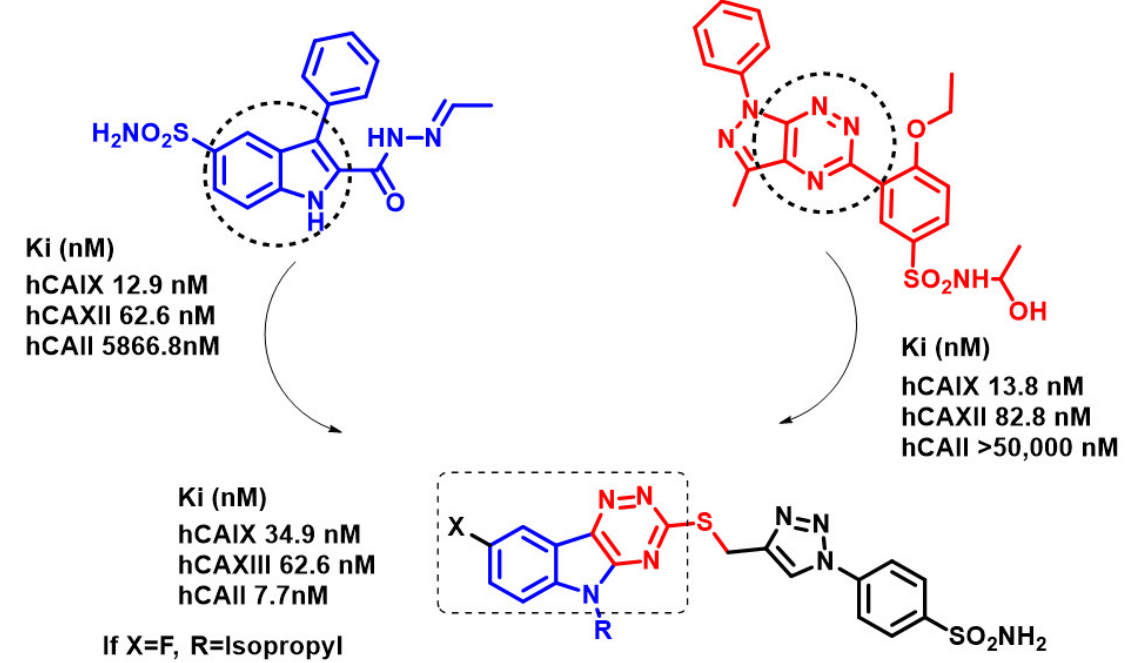
Figure 2. Design of target molecules by a molecular hybridization approach for hCA: human carbonic anhydrase